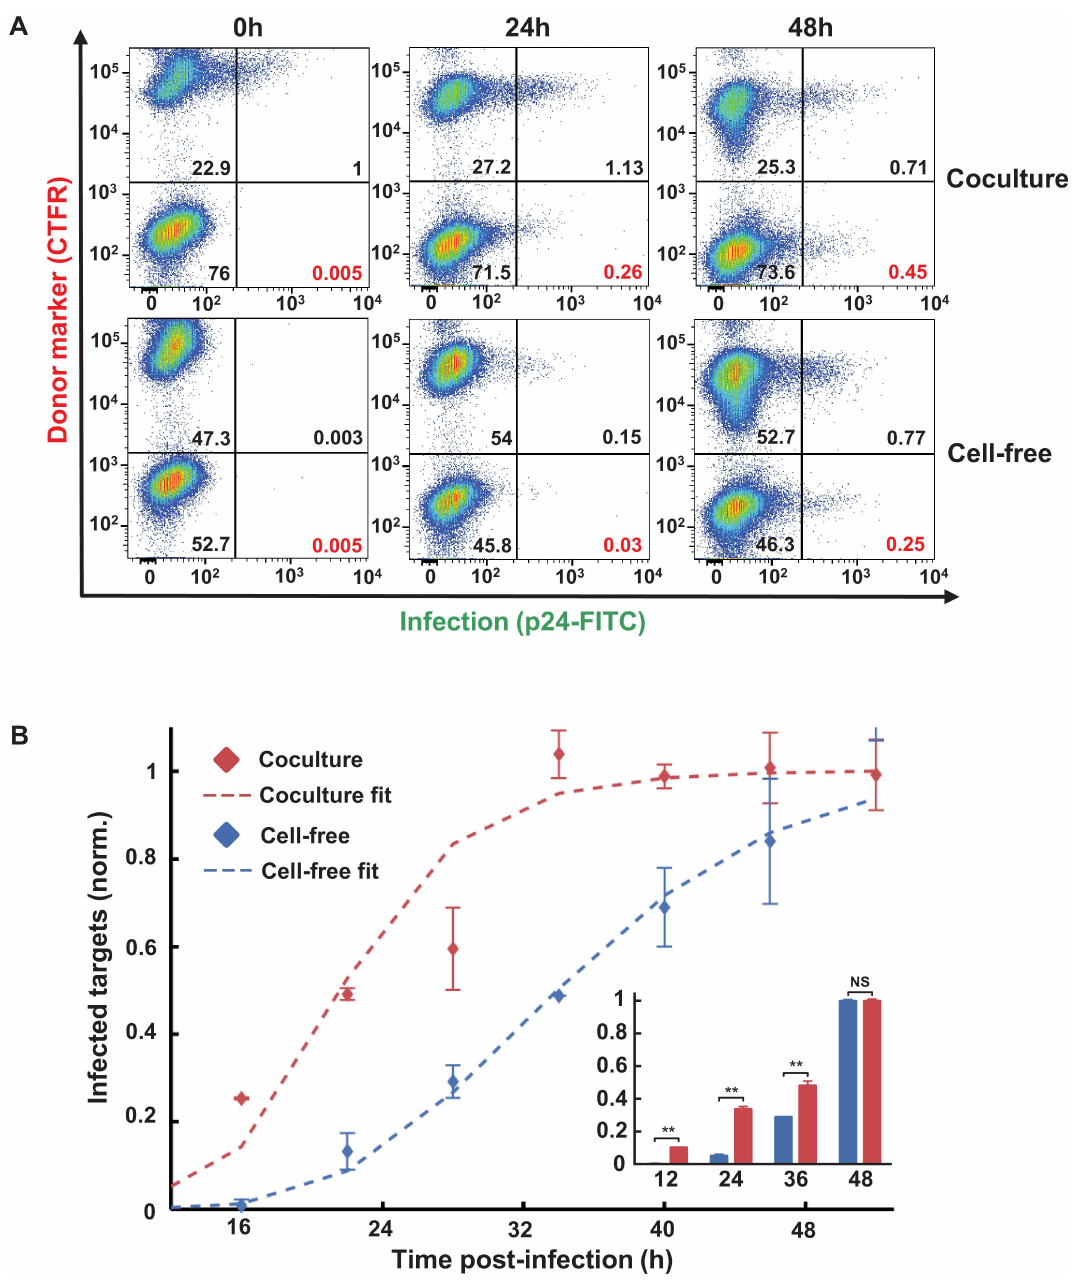
Fig 5. Earlier onset of HIV gene expression in PBMCs by coculture infection. ( A ) Gating strategy for detectably infected target cell frequency. Donors were labelledwith CTFR and infection was assayed by flow cytometry followingp24 staining for HIV Gag. Top row is coculture infection, bottom row is cell-free infection. Percent of infected targets in the population(bottom right quadrant) shown in red, and values for other subpopulations in black. ( B ) Timing of coculture (red) versus cell-free (blue) infection. Shown are means and standard errors of duplicates from one of three experiments with different blood donors. Frequencies of infected target cells were normalizedby infected target cell frequencyat 50 hours post infection. Means ± std of best fit Gamma distributions were 22.1 ± 9.3hours for coculture and 34.2 ± 9.1 hours for cell-free infection. Best fit MOI for the coculture infection was 5.0 (dashed red line). Inset: Infection of purified CD4 + T cells by cell- free HIV or autologous infected CD4 + T cells. Shown are mean and standard errors of duplicatesof the frequenciesof infected target cells normalized to the frequency of infected target cells at 48 hours post-infection. One of three experiments, each performed on purifiedCD4 + T cells from a different individual.Timing differences between cell-free and coculture in CD4 + T cells were statistically significant at 12, 24 and 36 hours post-infection (p < 0.01, two-tailed unpairedt- test corrected for multiple comparisons using the Sidak-Bonferroni